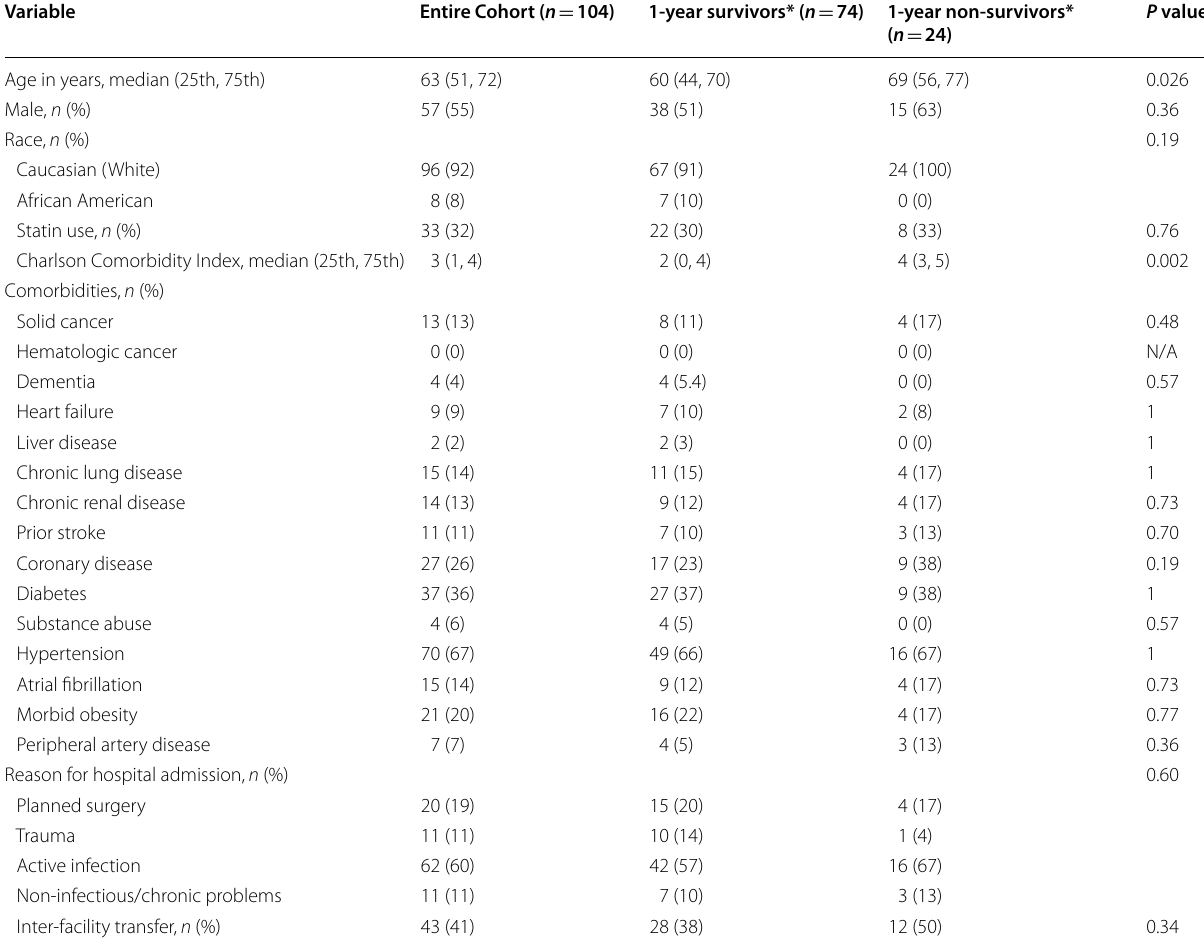
Table 1 Demographics, comorbidities, and reason for